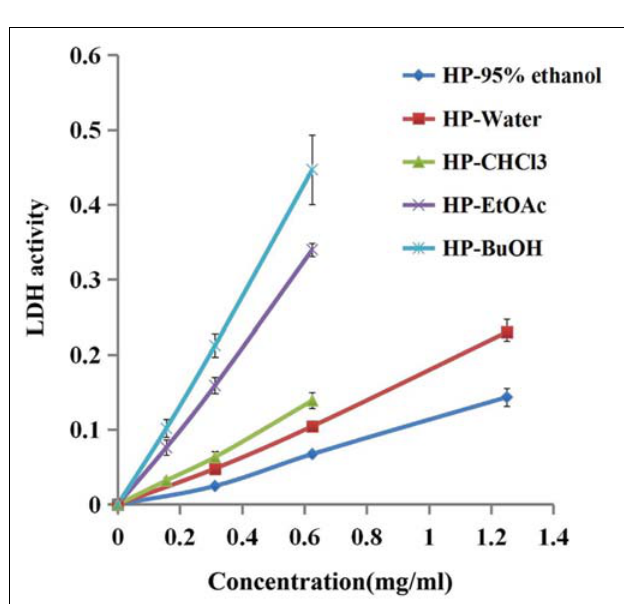
FIGURE 3 | Bacterial cell damage within the biofilm based on LDH activity in different test samples. The extracts of B. crassifolia leaves were serially diluted twofold in BHI broth containing 1% sucrose from 1/8 MIC to MIC respectively. The graph represents the actual concentrations of the MIC